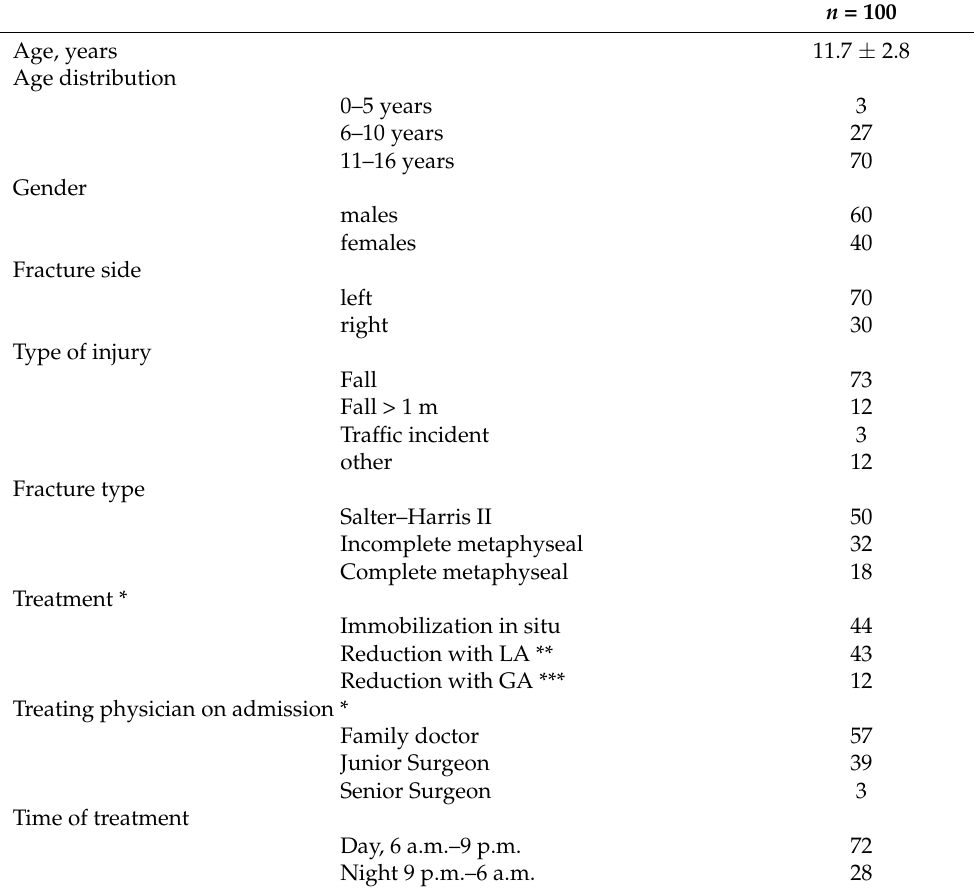
Table 3. Baseline characteristics of the patients, their injury types, and